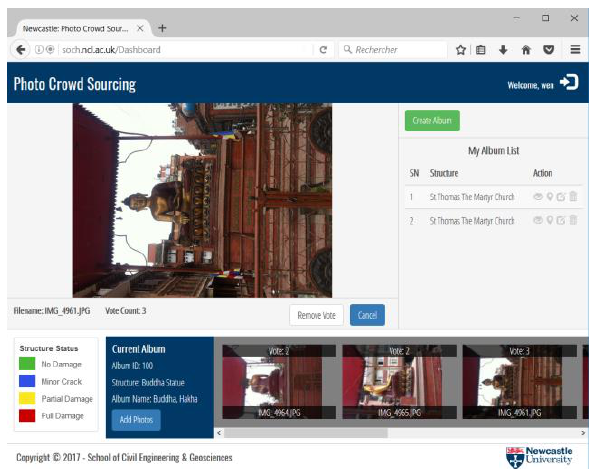
Figure 6. Voting illustration from a second